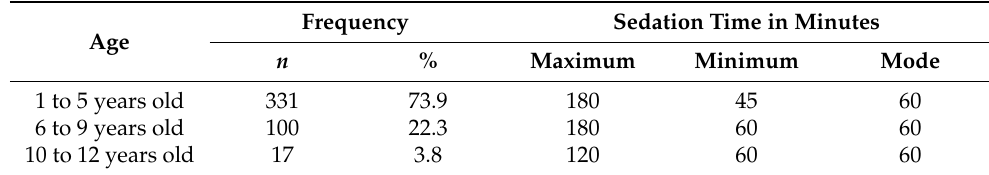
Table 1. Descriptive data on sedation according to